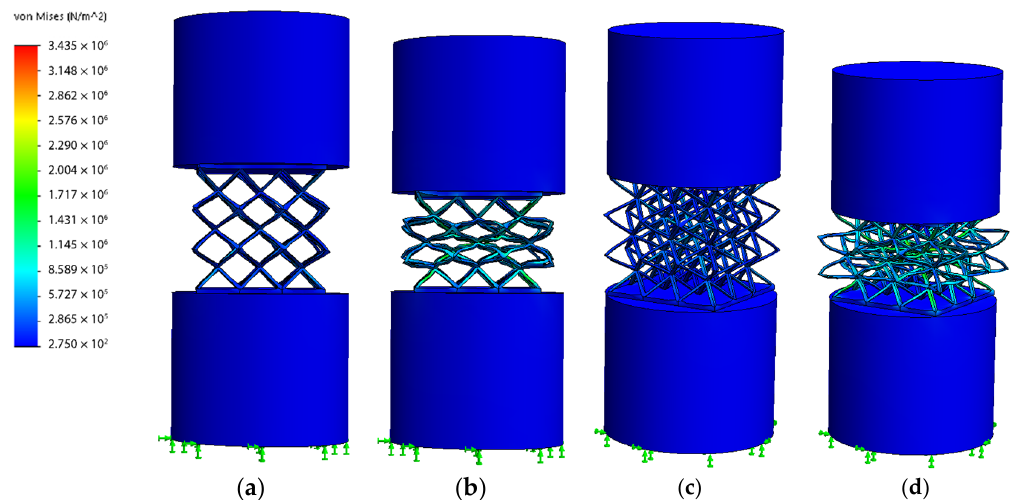
Figure 3. Simulation of the specimen in compression; ( a ) Inicial state Frontal view: ( b ) Specimen in compression state (Frontal view); ( c ) Inicial state (Perspective view); ( d ) Specimen in compression state (Perspective view).